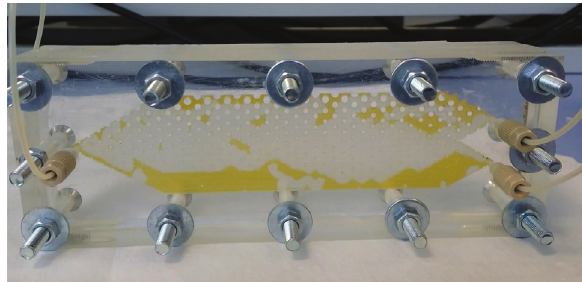
Fig. 3 – External view of the initial microseparator geome- try: single inlet is on the left-hand side whereas two outlets (one for each phase) are on the right-hand side of the picture.